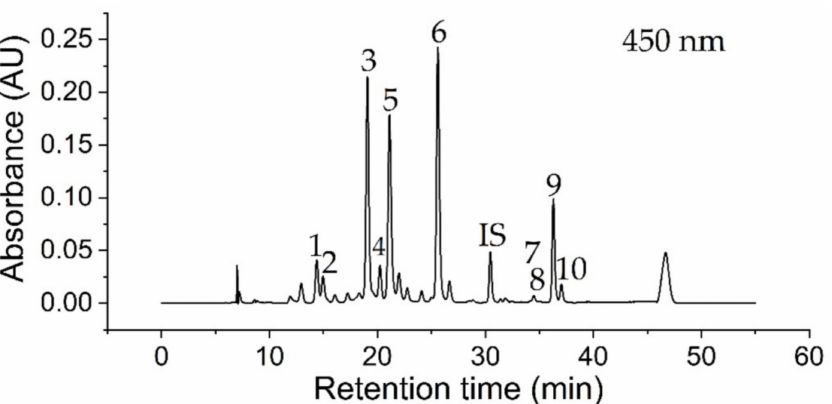
Figure 2. RP-HPLC-DAD chromatogram of a kale extract at 450 nm, using the HPLC parameters described in Section 2.5.2. Identified compounds are listed in Table 1, according to no. 1–10. Lucantin ® Yellow was used as internal standard (IS, t R = 30.45 min). A gradient peak caused by LC equilibration appears after 46.7